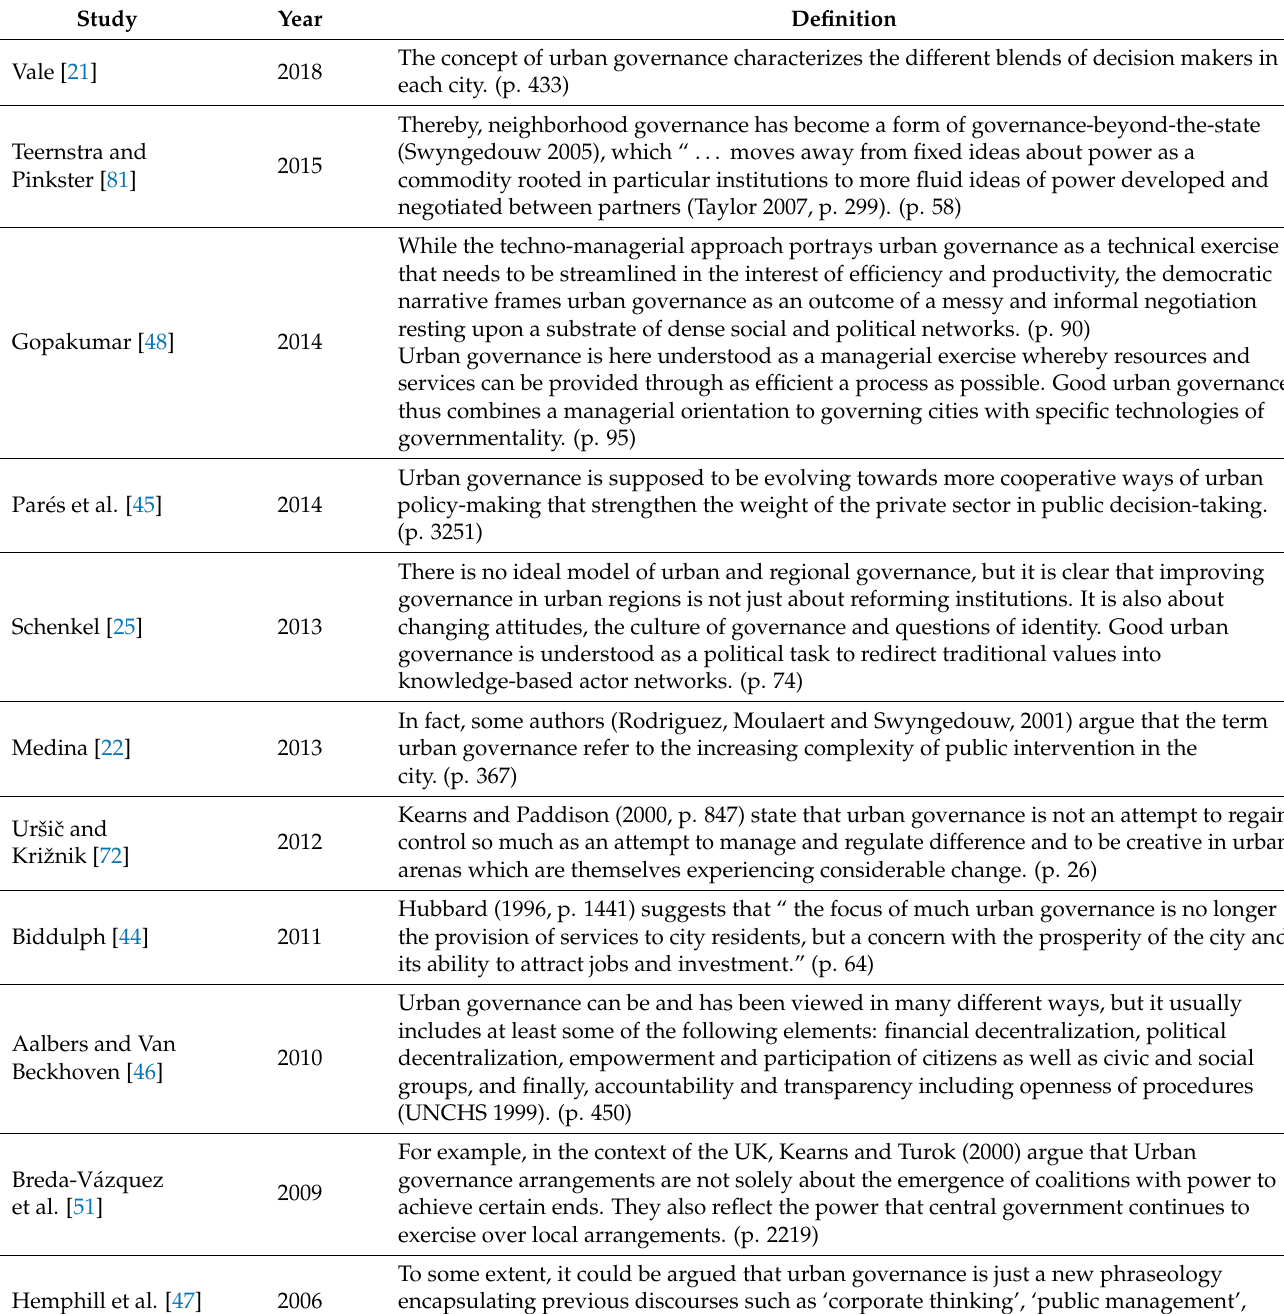
Table A3. Selection of broad urban governance definitions, sorted by year of